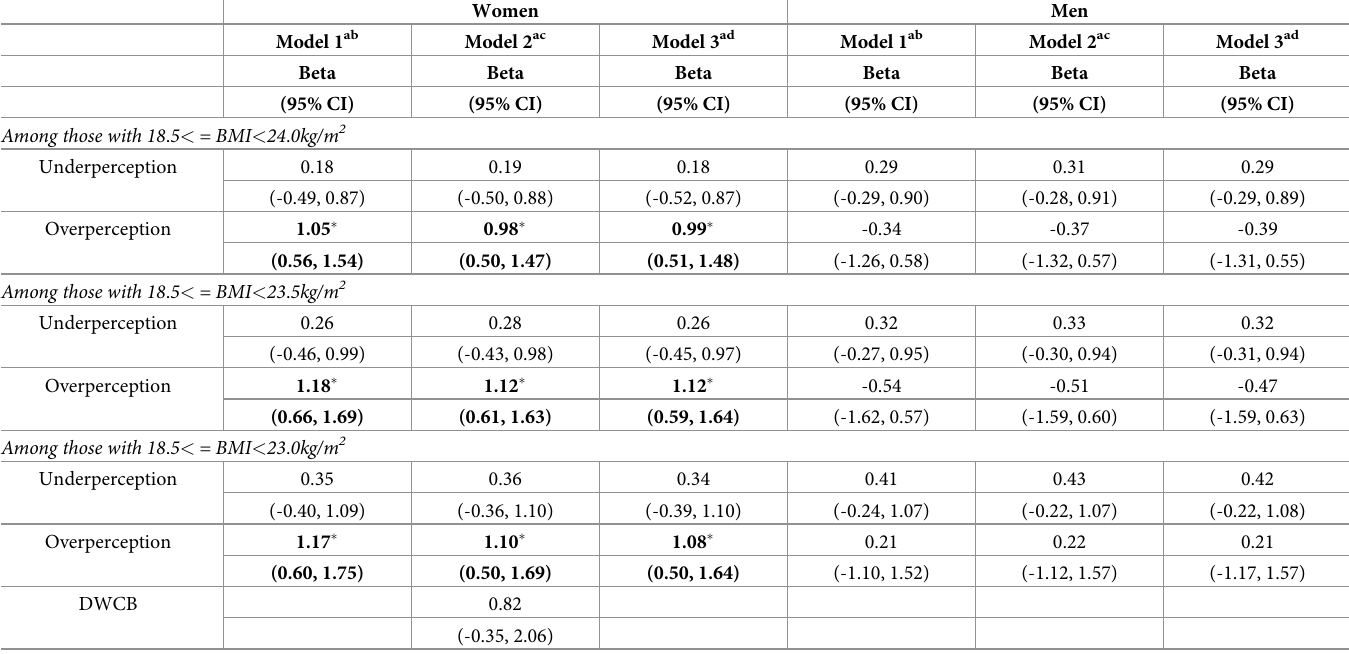
Table 7. Sensitivity analysis of multilevel linear models for depressive symptoms (PHQ-9K) among Korean women with varying cut-offs for normal weight